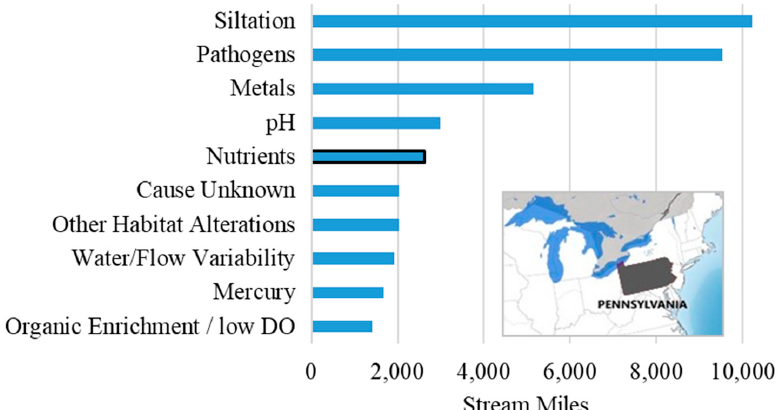
Figure 1. Leading causes of impairment by stream miles in Pennsylvania [4]. Coordinates for the midpoint of Pennsylvania are 40.8781° N and 77.7996° W.